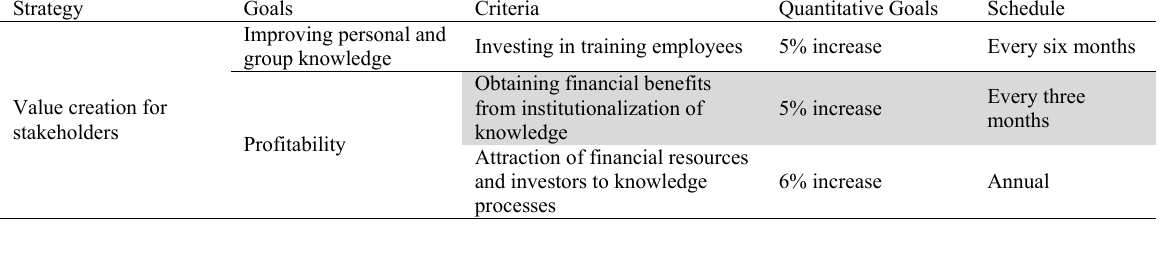
BSC for the financial dimension in knowledge management evaluation in petrochemical industries